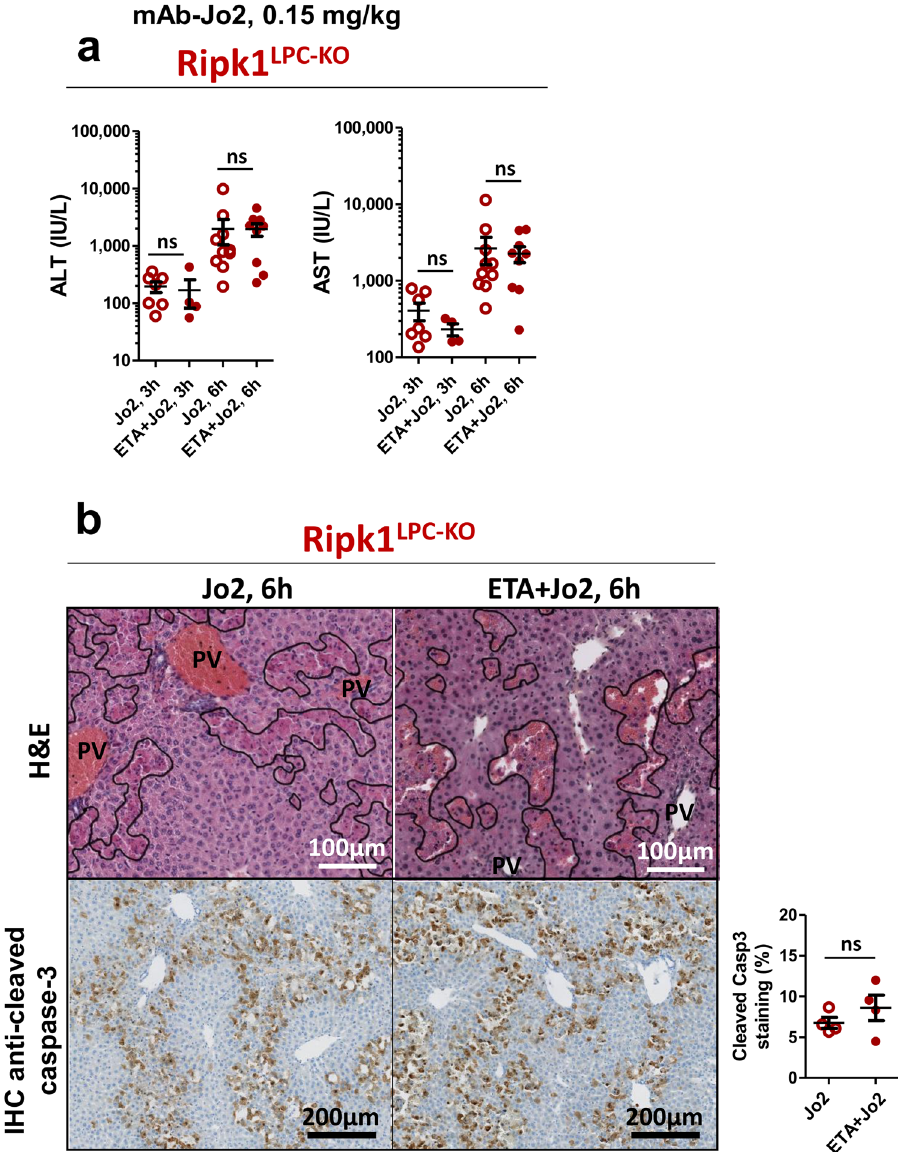
Figure 3. Fas-mediated liver injury in Ripk1 LPC-KO mice is independent of TNF- α . ( a ) Levels of serum ALT and AST (n = 4–10) in Ripk1 LPC-KO mice after 3 or 6 h mAb-Jo2 injection with a possible pre-treatment with ETA (ns: non-significant). Each circle or dot represent an individual. ( b ) Pictures of liver tissue sections, stained by H&E (upper panels) or analysed by IHC for cleaved caspase-3 (lower panels), issued from Ripk1 LPC-KO mice, 6 h after mAb-Jo2 injection with a possible pre-treatment with ETA. Signal quantification of cleaved caspase-3 (lower right